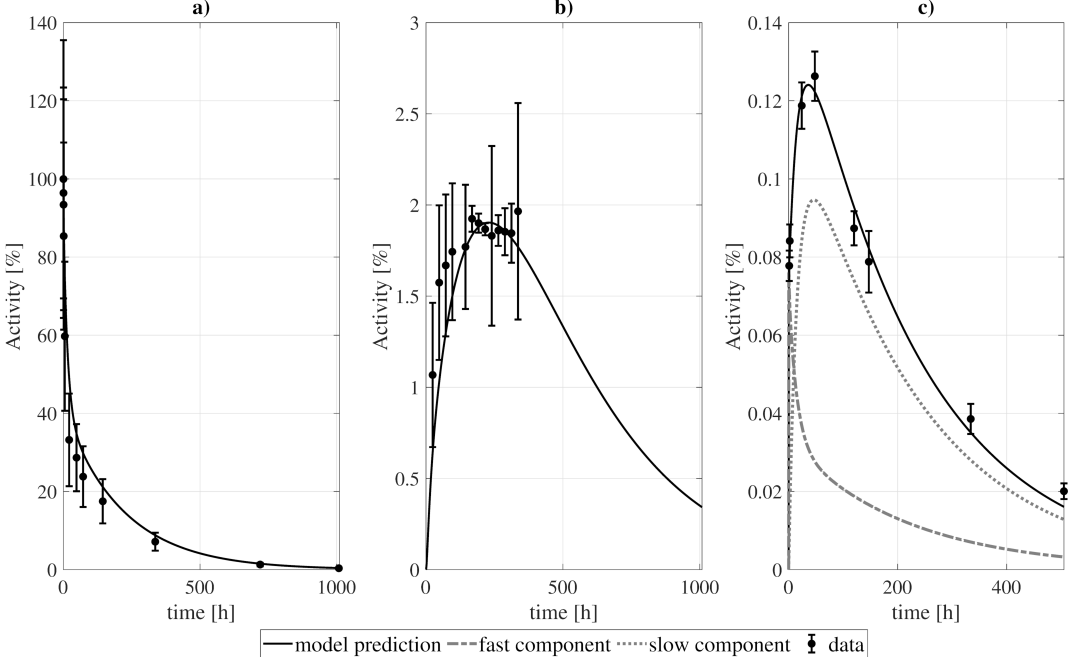
Figure 5. Model fitting to ( a ) blood, ( b ) urine, and ( c ) tumor data. For the tumor, a standard deviation of 5% of the PET experimental measurements and 10% for the SPECT ones (last 3 points) were taken. For blood and urine, the standard deviation represents the dispersion of the patient group of [8]. Experimental and modeled activities take into account the physical decay of the 131